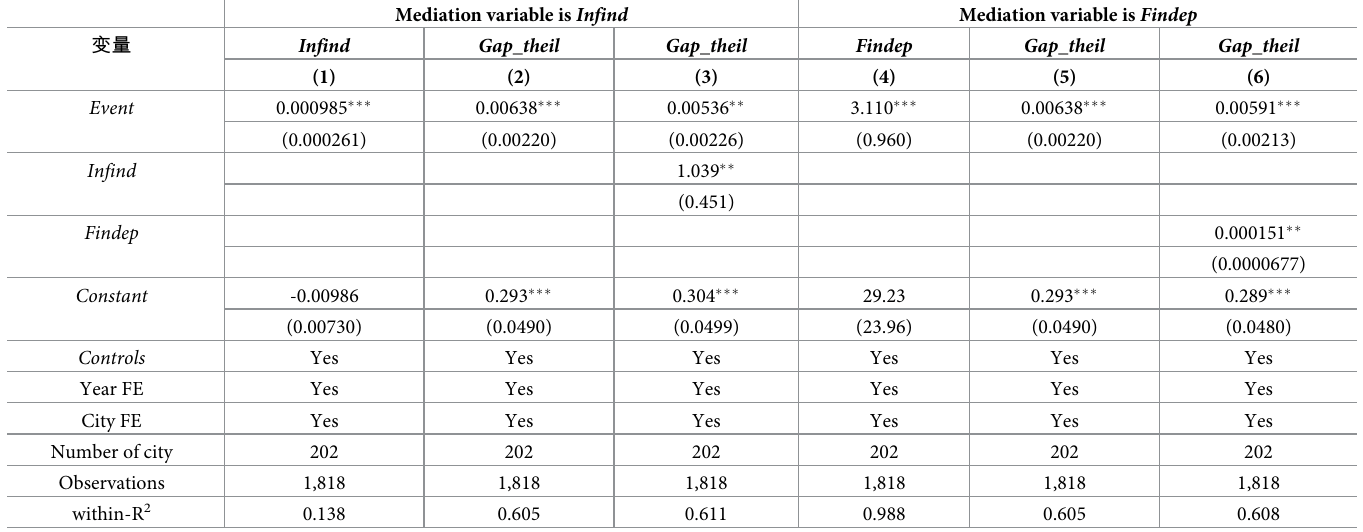
Table 11. Test results of "Broadband China" exogenous